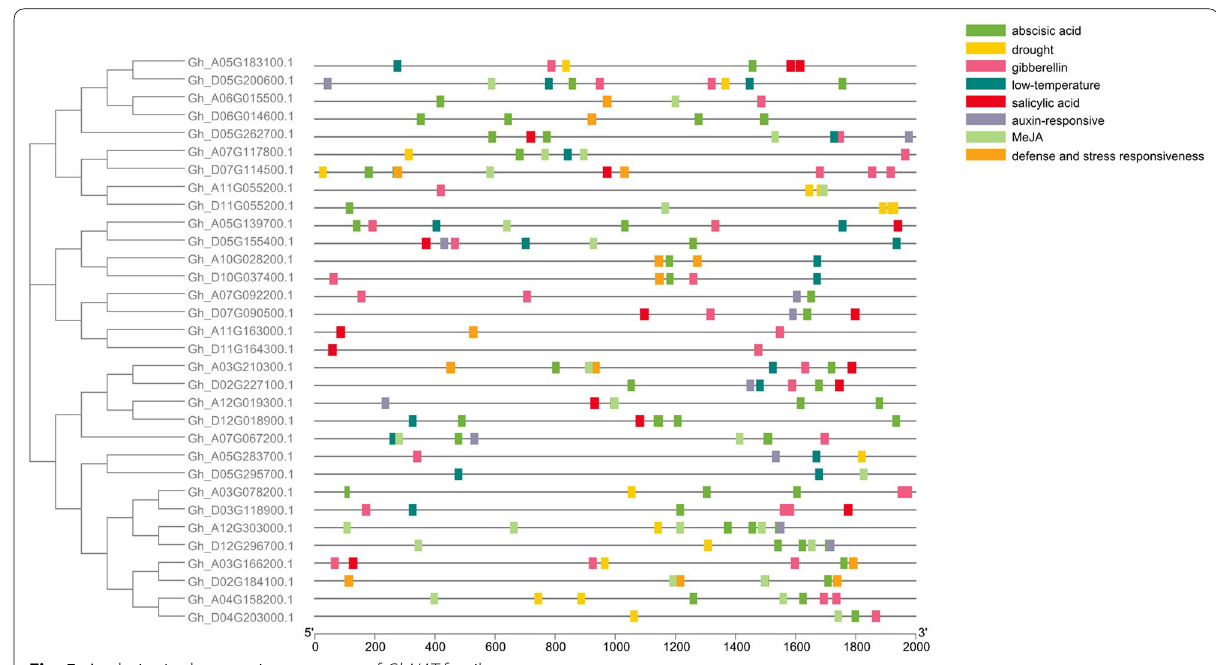
Fig. 5 Analysis cis -elements in promoters of GhNAT